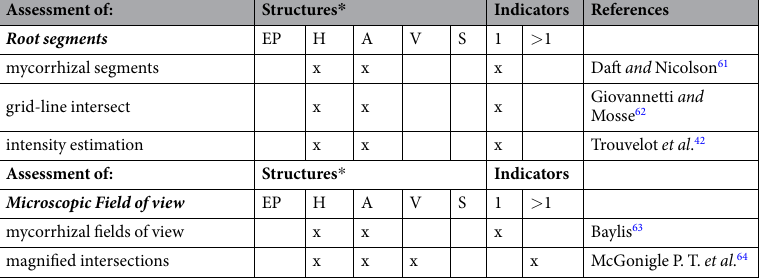
Table 1 – percentage calculation method, grid-line intersect method and magnified intersection method – for each of them the post-processing of collected data and observations being required 41 . Another useful system for rapid evaluation is the root segment estimation proposed by Trouvelot 42 , but the classes of assessment of